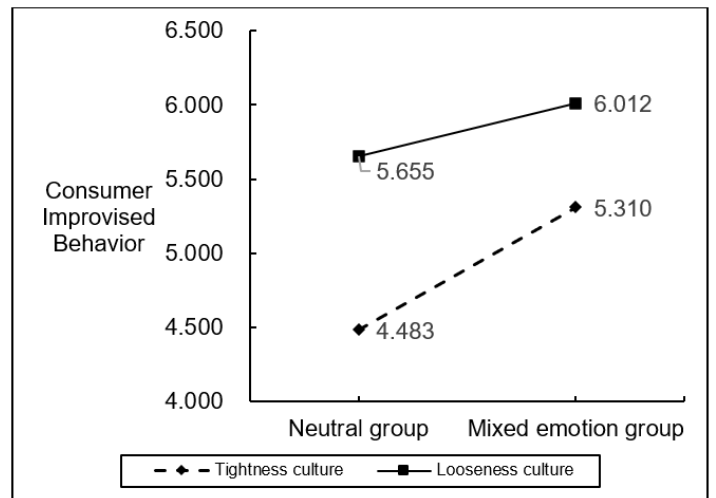
Figure 6. The moderating role of tightness-looseness culture in the relationship between mixed emotions of awe and anxiety and consumer improvisational behavior. Table 3. Model path effects